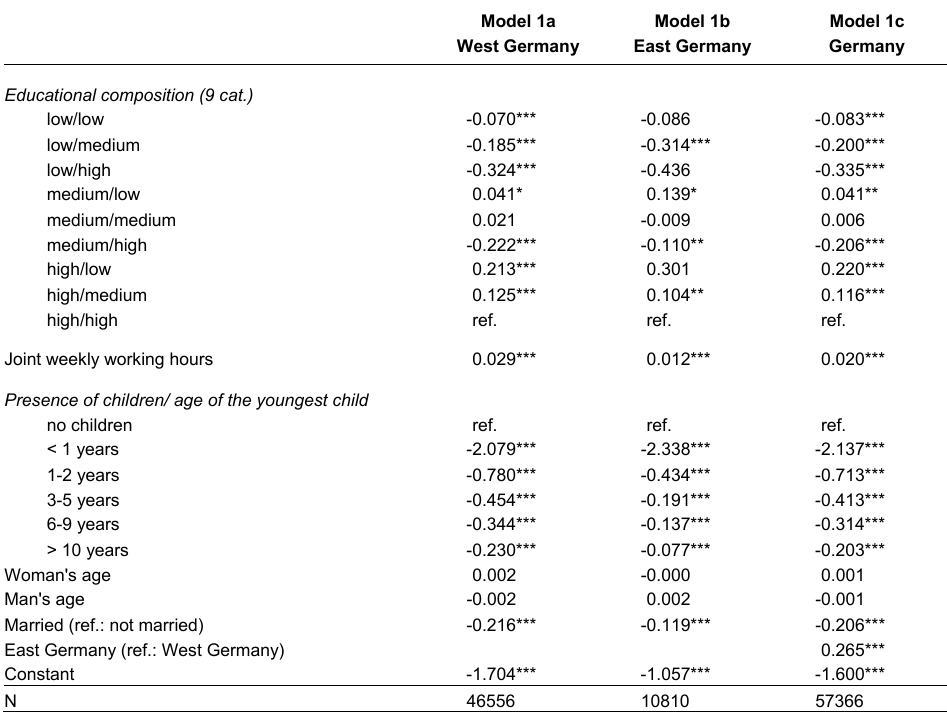
Table A2 : General Linear Models for women’s share of weekly working hours (by re- gion) – educational composition in 9 categories